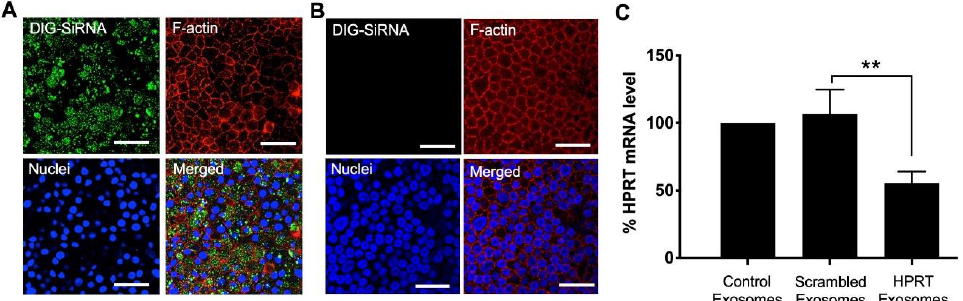
Figure 3. Exosome-mediated delivery of DsiRNA effectively silences target gene in HAE. DsiRNA